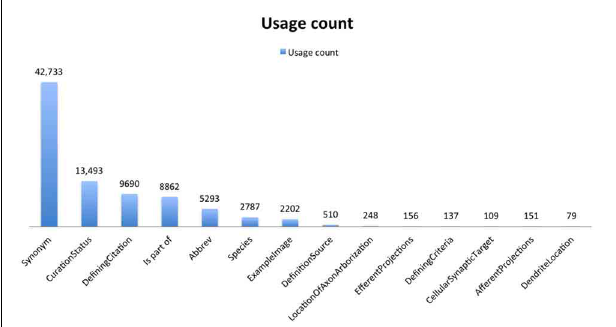
FIGURE 6 | Overview of key relations. Derived from data that appears on the web at http://neurolex . org/wiki/Special:Properties .